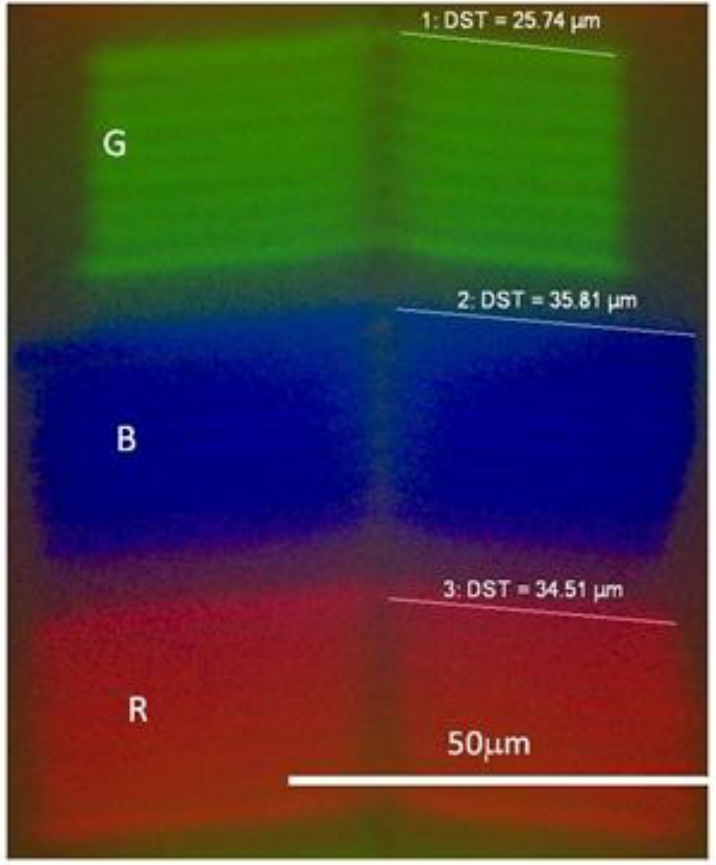
Figure 1. Microscope image of RGB OLED on android screen for Smartphone HTC Desire. Approximate dimensions of each pixel are